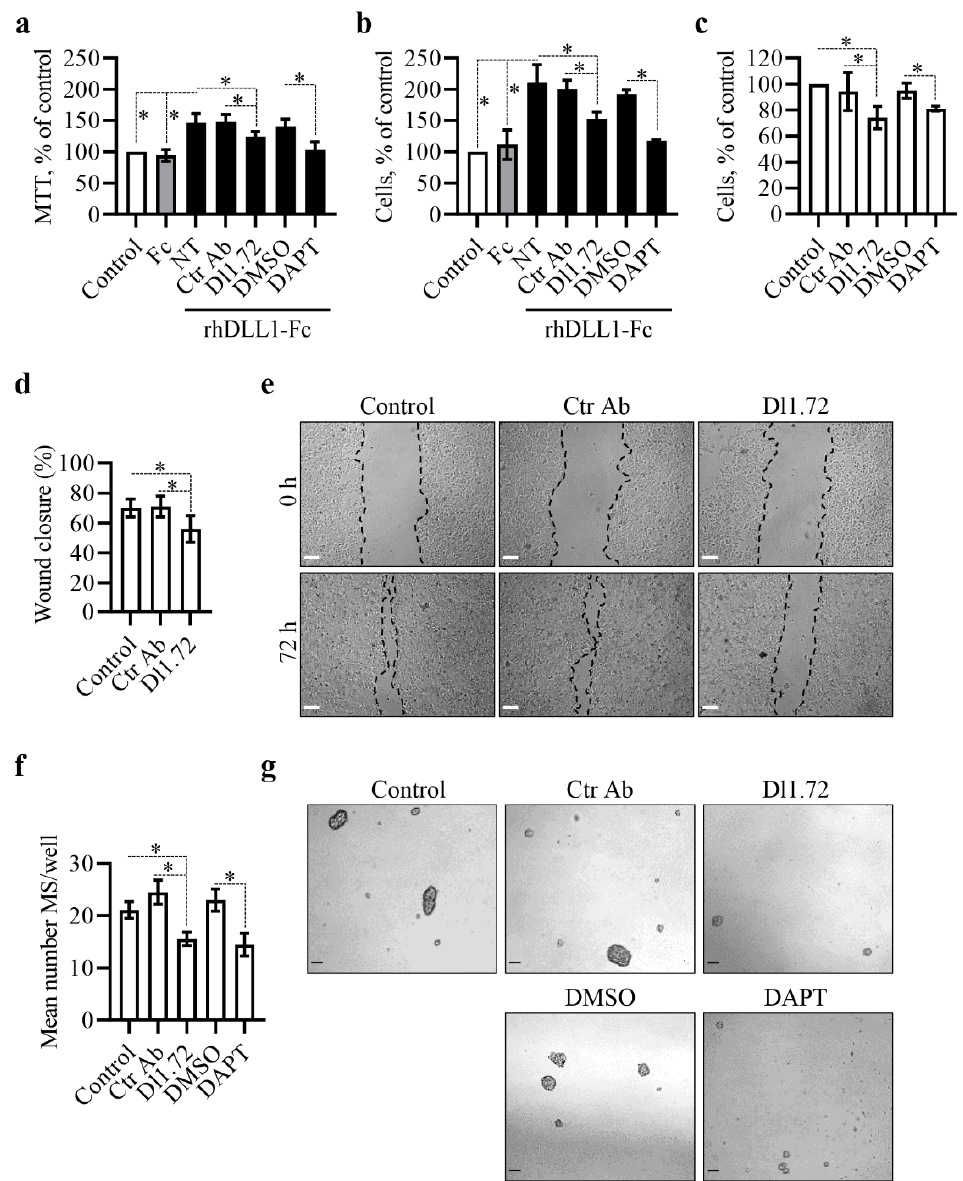
Figure 3. Anti-DLL1 Dl1.72 impairs MCF-7 cell proliferation, migration and mammosphere formation. ( a , b ) Effect of Dl1.72 in MCF-7 cell proliferation induced by DLL1. Cells were cultured in uncoated wells (control) or wells coated with Fc or rhDLL1-Fc proteins in the absence (NT) or presence of Dl1.72, Ctr Ab (10 µ g/mL), DAPT or DMSO, and cell growth was analyzed after 72 h by the ( a ) MTT method and ( b ) trypan blue exclusion microscopy. Values were calculated as percentages relative to those obtained in control cells. The graphs represent mean percentage ( ± SD, n = 4). ( c ) Effect of Dl1.72 on cell proliferation in the absence of DLL1-induced proliferation. At 16 h following seeding, cells were left untreated or treated, as indicated above, and cell growth was analyzed after 72 h by trypan blue exclusion microscopy. The graph shows the mean percentage ( ± SD, n = 6) of cells relative to control untreated cells. ( d , e ) MCF-7 cells seeded and treated as in ( c ) were scratched at 90% confluence, and wound closure was evaluated by microscopy. ( d ) Mean percentage values ( ± SD, n = 3) of wound closure at 72 h after wounding. ( e ) Representative images taken at the indicated times post-wounding from the three independent experiments. Scale bars, 200 µ m. ( f , g ) Effect of Dl1.72 on MCF-7 BCSC population. Single cell suspensions were plated in mammosphere (MS) formation medium in ultra-low attachment plates and not treated (control) or treated as in ( c ). ( f ) Graph shows mean number ( ± SD, n = 5) of MS after 5 days of culture. ( g ) Representative images from experiments. Scale bars, 50 µ m. *, p < 0.05 (two-tailed paired Student t -test).